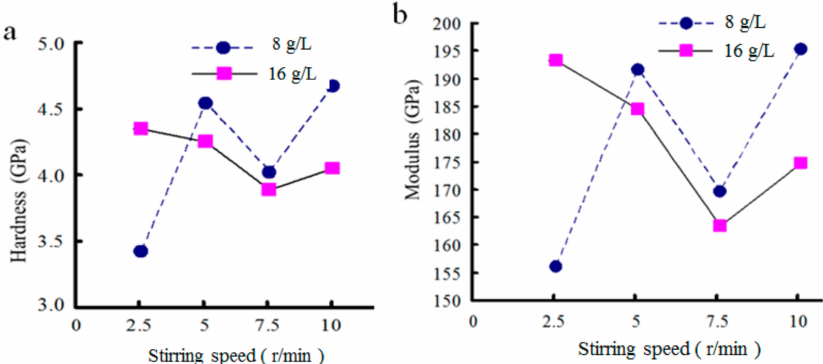
Figure 13. E ff ects of stirring speed on mechanical properties of composite coatings: ( a ) Hardness, and ( b ) elastic